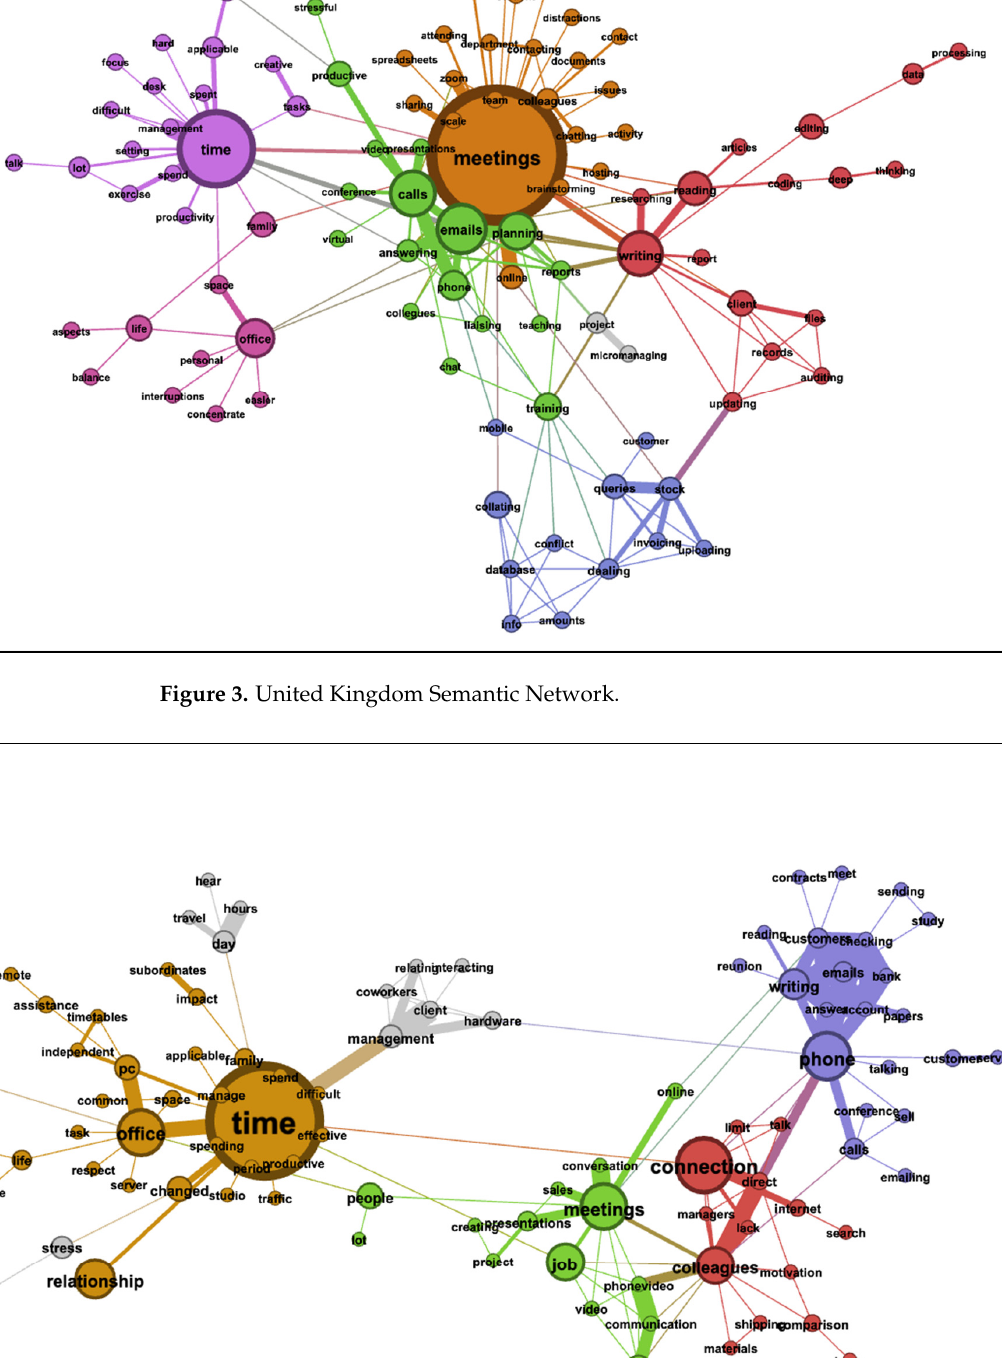
Figure 2. Germany Semantic Network.